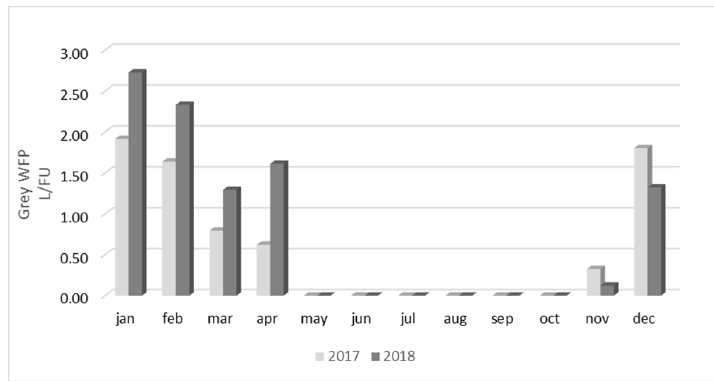
Figure 11. Blue water footprint regarding case study II—Alentejo region, for both years of monitoring.